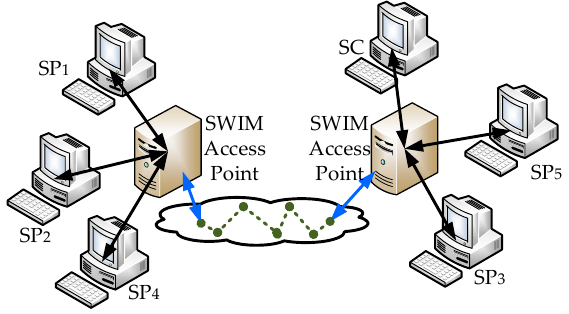
Figure 8. SWIM simulation test platform.